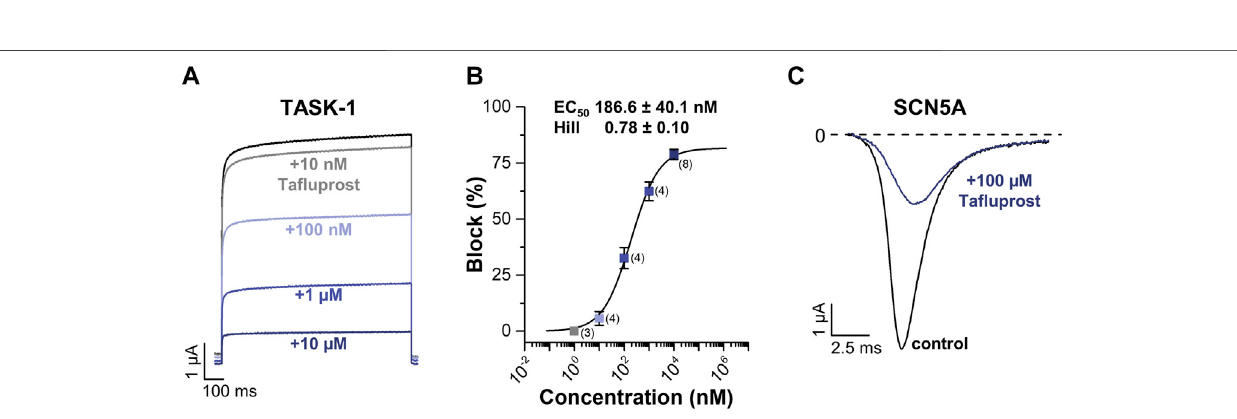
FIGURE9|(A) RepresentativecurrenttracesofTASK-1intheabsence(black)orthepresenceofincreasingconcentrationsofta fl uprost(colored). (B) Percentage of block of outward currents in TASK-1 channel by ta fl uprost. Each point is the mean ± SD of 3-8 determinations. (C) Representative current traces of NaV1.5 (also referred as to SCN5A) before (black) and after (blue) application of 100 µM ta fl